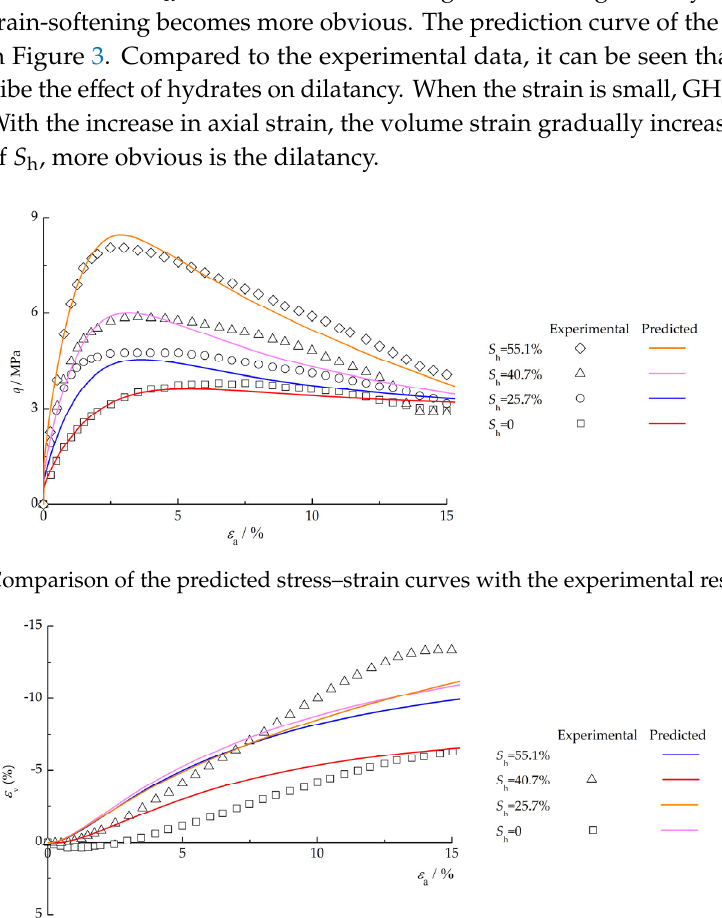
Figure 3. Comparison of the predicted volume strain curves with the experimental results [22].